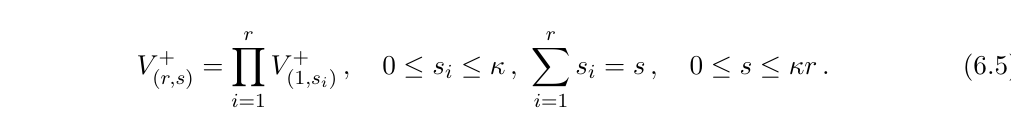
Figure 34 . (a) When (cid:20)r (cid:20) s , a setup with s (cid:0) (cid:20)r F1 and r 1 junction with a 1 string ending on the D3. (b) When 0 (cid:20) s (cid:20) (cid:20)r , a setup with 1 ( r;s ) i = 1 ; (cid:1) (cid:1) (cid:1) ; r , 0 (cid:20) s i (cid:20) (cid:20) , can be deformed into a junction with a 1 with s = P s i i